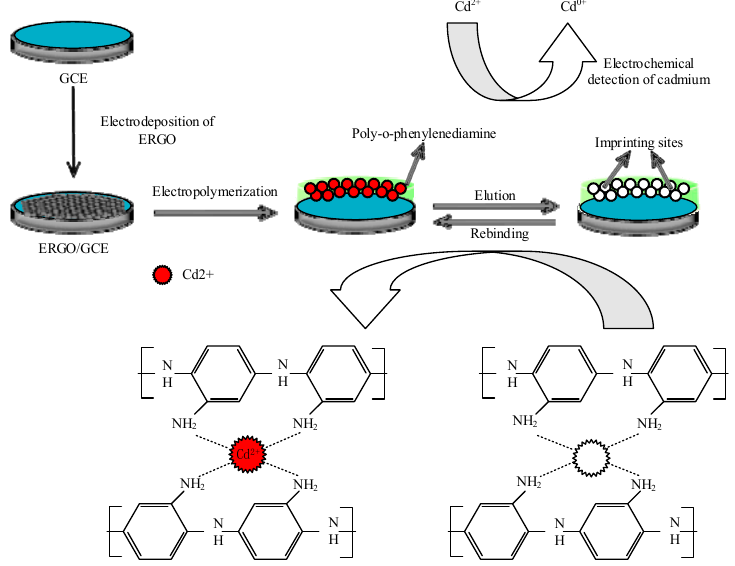
Figure 1. Detail procedure diagrams for fabrication of the IIP/ERGO/GCE.